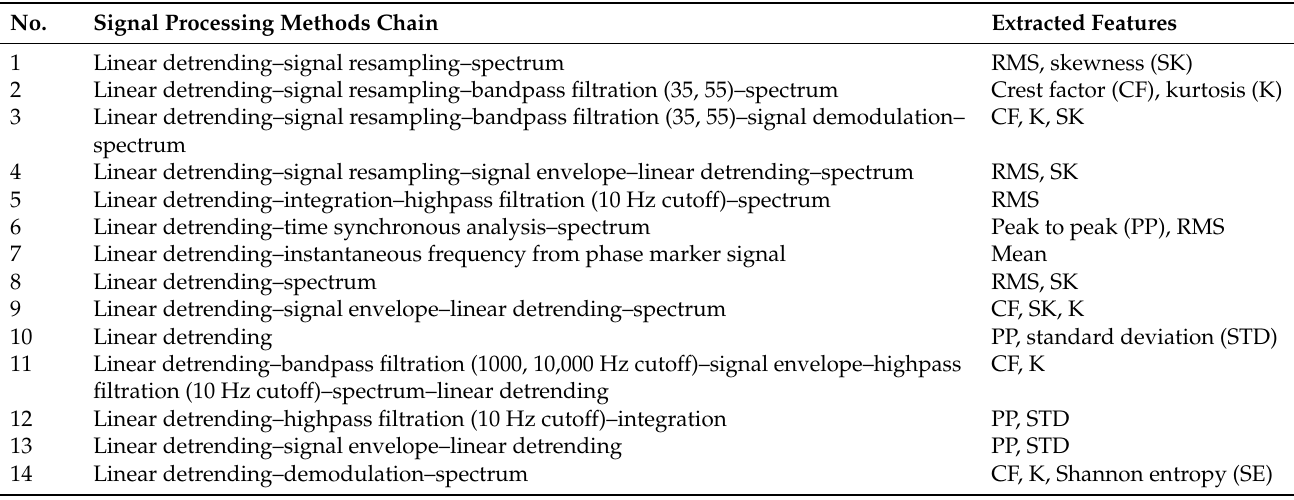
Table 2. Signal processing methods and extracted features.